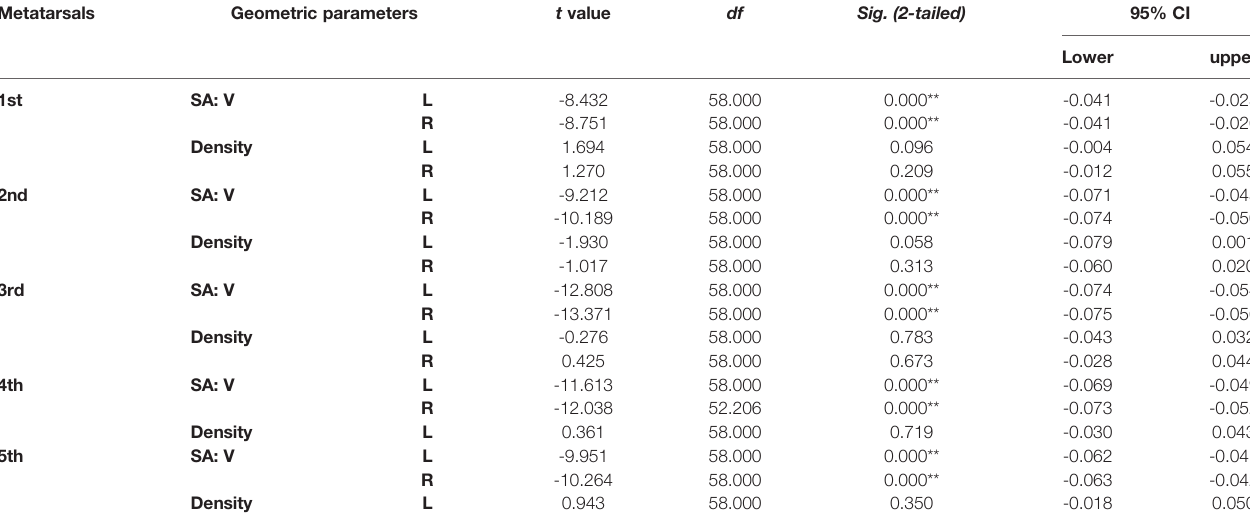
TABLE 5 | Independent sample t -test results of SA: V (mm -1 ) and bone density (HU/1024) of metatarsal bone in vivo between sexes.